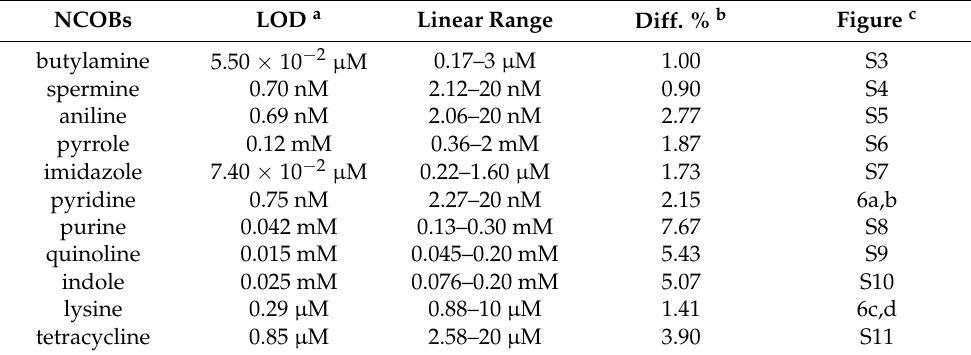
Table 2. Key parameters for the detection of NCOBs using UV-vis based, C-dots derived sensing assays. NCOBs LOD a Linear Range Diff. % b